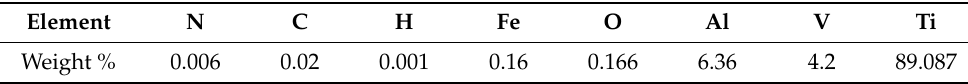
Table 1. Chemical composition of Ti6Al4V rollers.